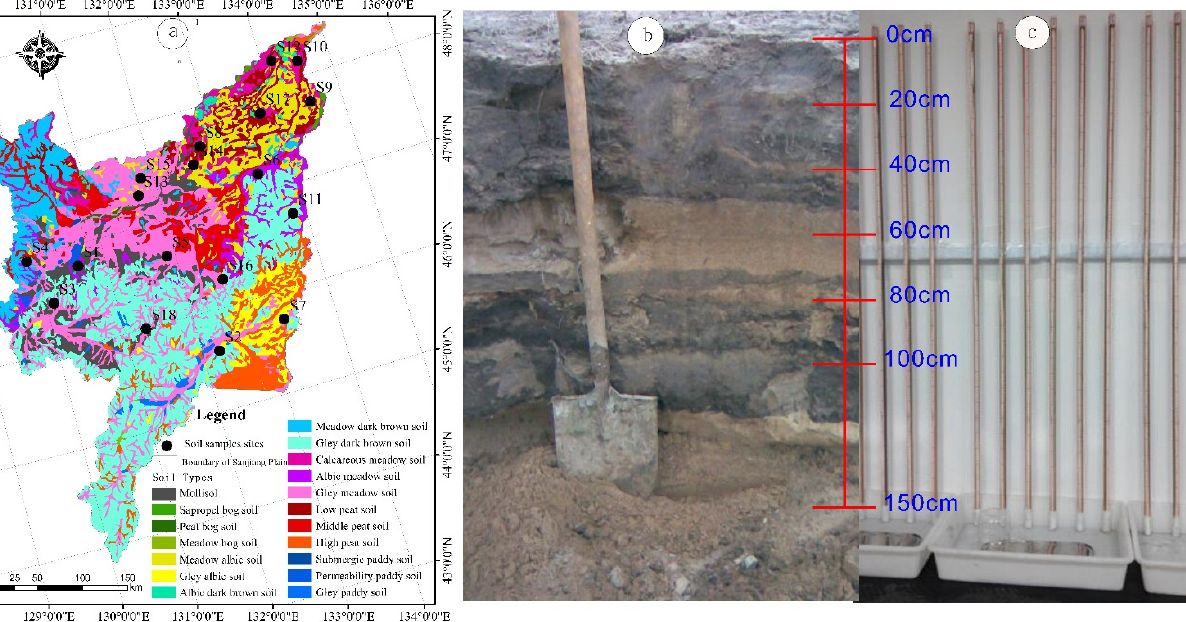
Figure 7. Soil sampling locations and soil types in the Sanjiang Plain ( a ); soil profile ( b ); and vertical tubes used for measuring capillary rise ( c